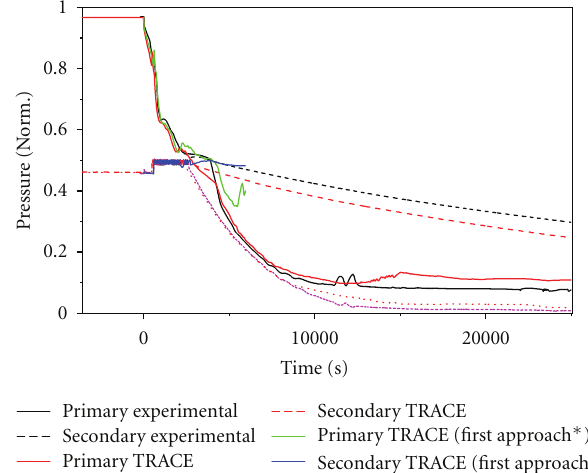
Figure 10: Primary and secondary pressures for Test 6-2 using both nodalizations of the SG’s primary and secondary sides.